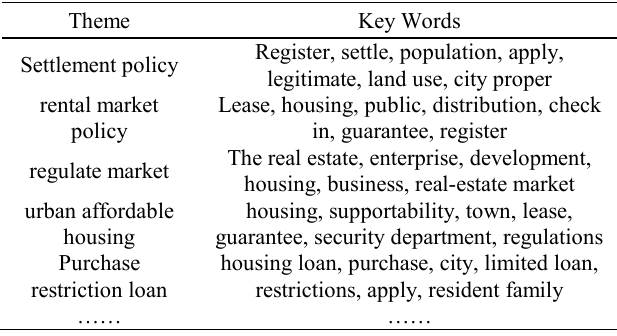
Figure 4. Cloud map visualization of policy keywords in